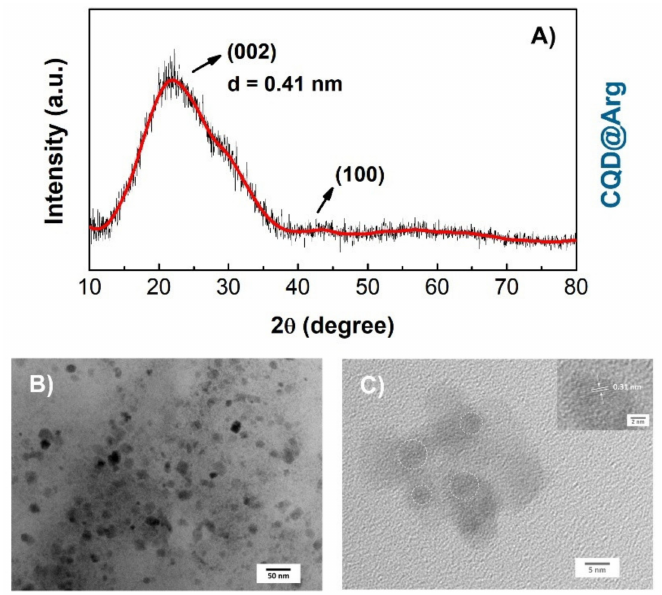
Figure 2. ( A ) XRD pattern of CQD@Arg, ( B ) TEM images showing CQD@Arg nanoparticles, and ( C ) HR-TEM image showing lattice spacing of d = 0.31 nm.